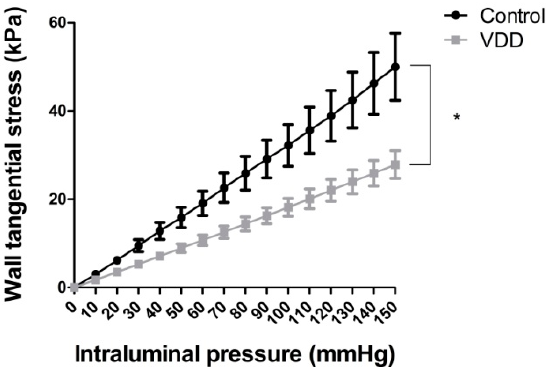
Figure 2. Tangential stress (kPa) of coronary arterioles in passive state repeated measures ANOVA, Bonferroni. Mean ± SEM, n = 8–8. * p < 0.05.